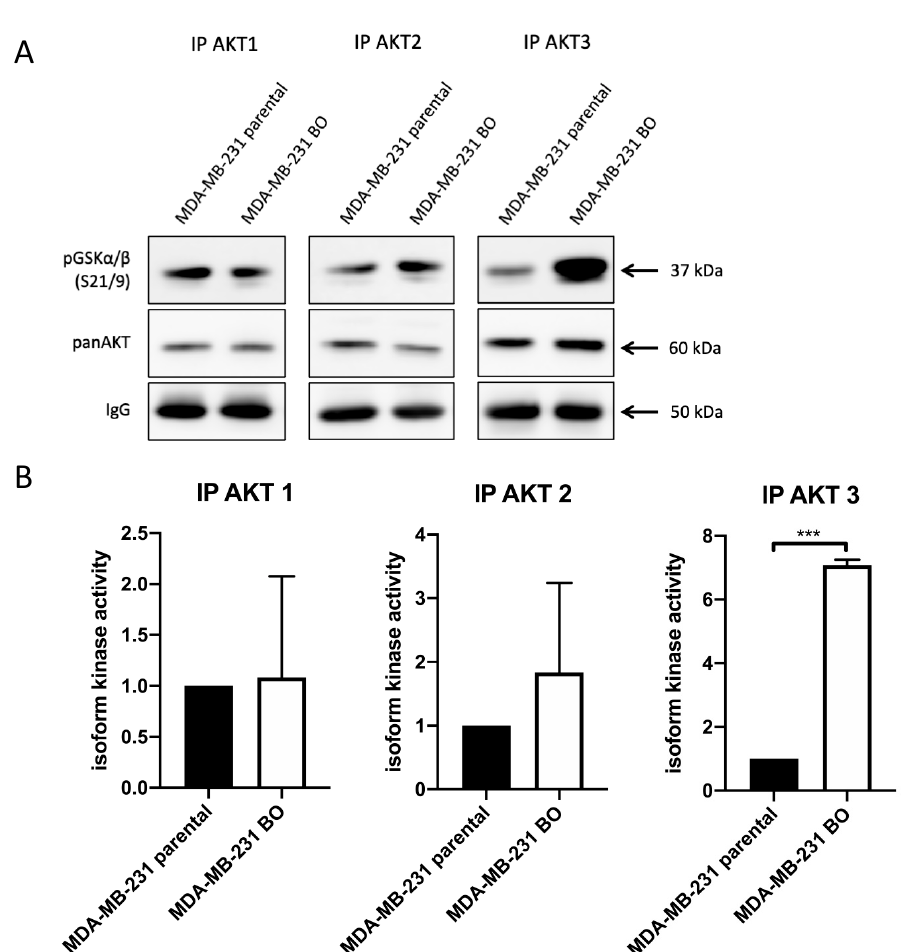
Figure 3. AKT3 activity is elevated in bone-seeking 231-BO cells in an in vitro kinase assay: ( A ) Isoform-specific in vitro AKT kinase assay was performed to determine differences in the bone- seeking subline 231-BO compared to parental MDA-MB-231 cells. After AKT isoform immunopre- cipitation, GSK3 α / β fusion protein was used as an AKT substrate. Level of pGSK3 α / β S21/9 was detected as an indicator of AKT isoform activity. Antibodies directed against pGSK3 α / β S21/9, panAKT, and mouse IgG were used after Western blotting. ( B ) Quantification of AKT isoform kinase activity indicated by phosphorylation of pGSK3 α / β was performed from Western blot analysis of triplicates and normalized to intensity of IgG signals. Bars indicate mean relative to MDA-MB-231 parental cells with SD; *** = p <